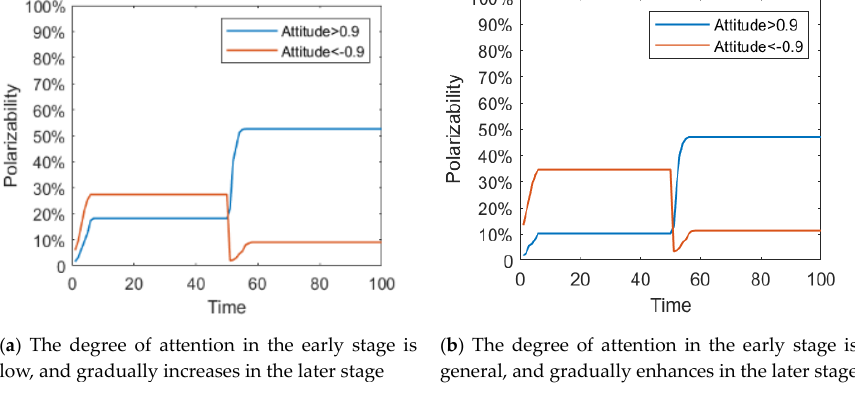
Figure 11. Histogram of group attitude with changes of individual attention. ( a ) The degree of attention in the early stage is low, and gradually increases in the later stage; ( b ) The degree of attention in the early stage is general, and gradually enhances in the later stage; ( c ) The degree of attention in the early stage is high, and gradually decreases in the later stage; ( d ) The degree of attention in the early stage is high, and continuously enhances in the later stage.